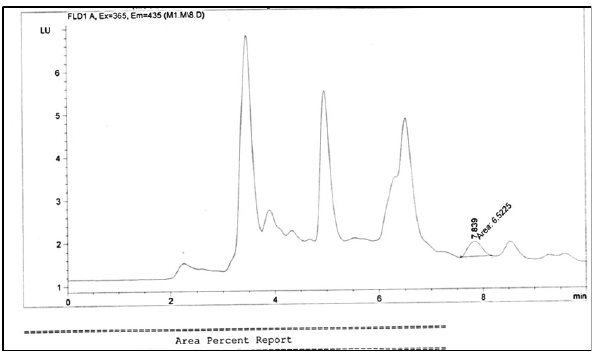
Figure 2: HPLC Chromatogram of Milk based Mithae sample.